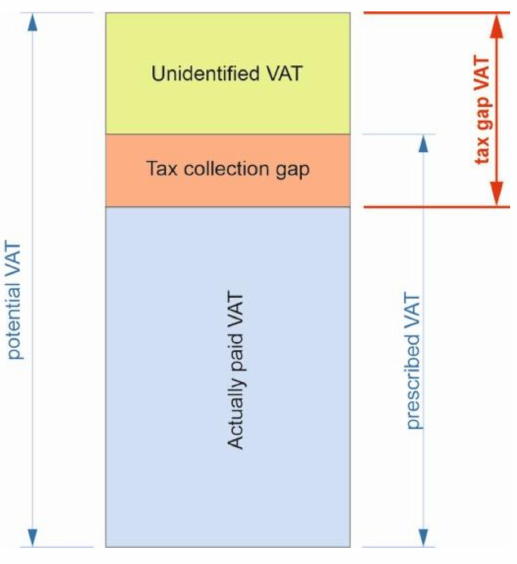
Figure 1. Structure of VAT potential